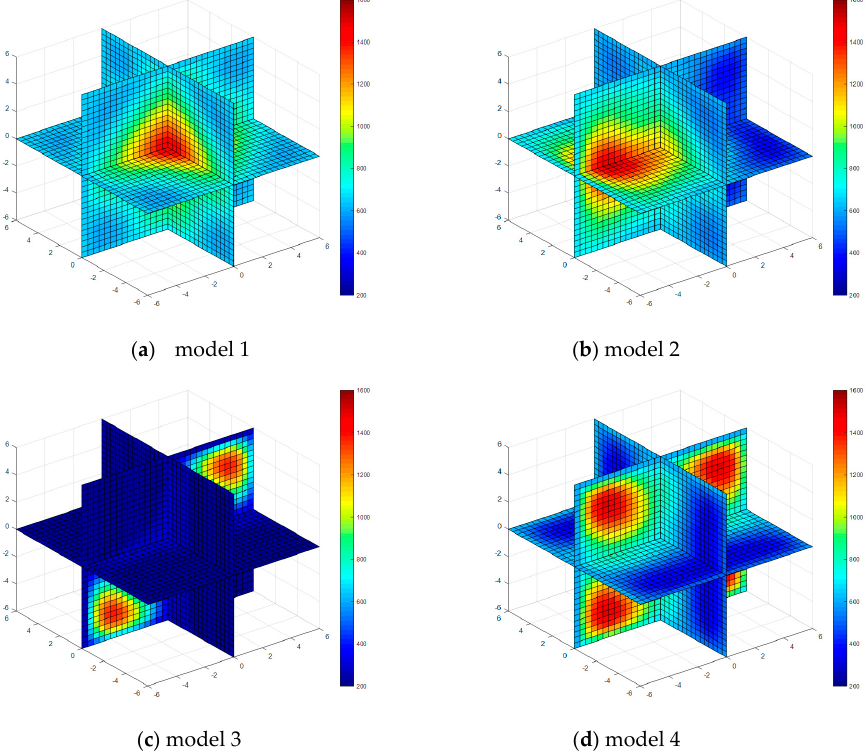
Figure 7. Diagram of reconstructed temperature fields by SIRT.